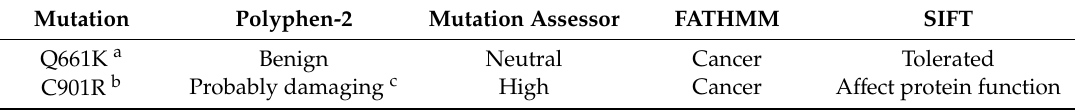
Table 2. Functional e ff ects of the Q661K and C901R rare mutations as predicted by multiple bioinformatics